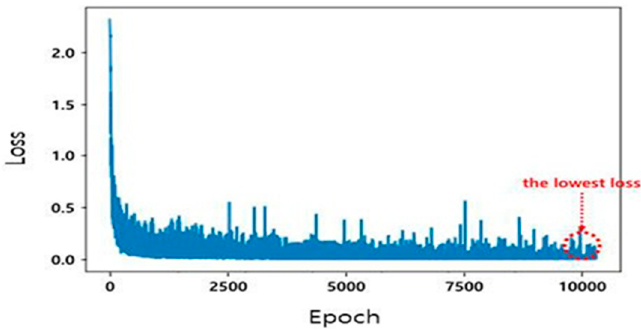
Figure 15. Loss value according to epoch for the PASCAL VOC 2012 database.